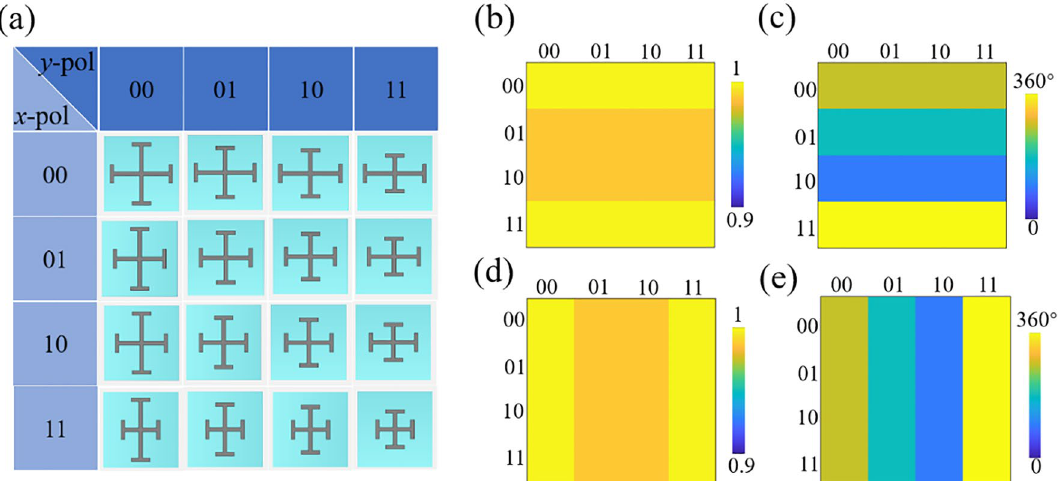
Figure 2. ( a ) Details of the designed 16 coding elements. Phase responses of the coding elements along the horizontal and vertical axes indicate the operational state under x - and y -polarized incidences. ( b , c ) The reflection amplitude and phase responses of the 16 coding elements under x -polarized incidence, respectively. ( d , e ) The reflection amplitude and phase responses of the 16 coding elements under y -polarized incidence,